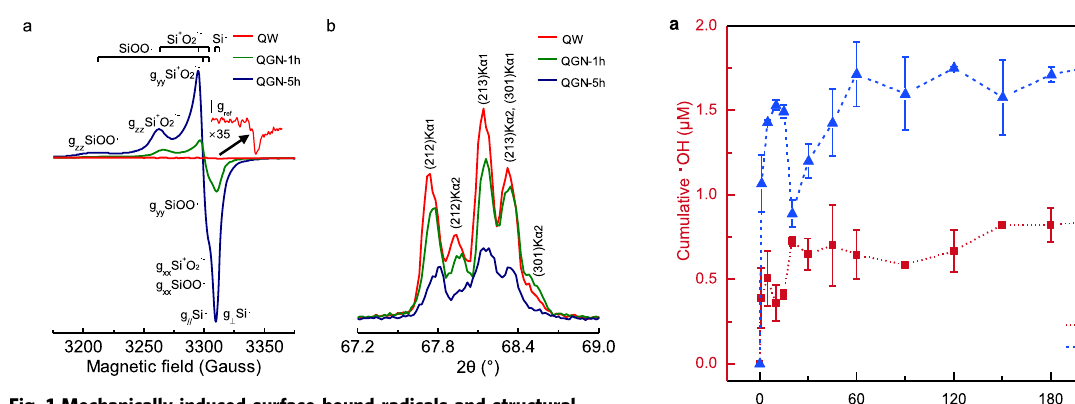
Fig. 1 Mechanically induced surface-bound radicals and structural amorphization of quartz. a EPR spectra of quartz before and after being ground in N 2 for 1 and 5 h. Three types of surface-bound radicals were identi fi ed, i.e., peroxy radical ( ≡ SiOO • , g zz = 2.064; g yy = 2.007; g xx = 2.002), surface-bound superoxide ion ( ≡ Si + O 2 • − , g zz = 2.044; g yy = 2.010; g xx = 2.002), and E ′ center ( ≡ Si • , g // = 2.001; g ┴ = 2.000). b XRD patterns of quartz washed by 10 wt.% hydro fl uoric acid (QW) and quartz ground in N 2 atmosphere for 1 h (QGN-1h) and 5 h (QGN-5h).